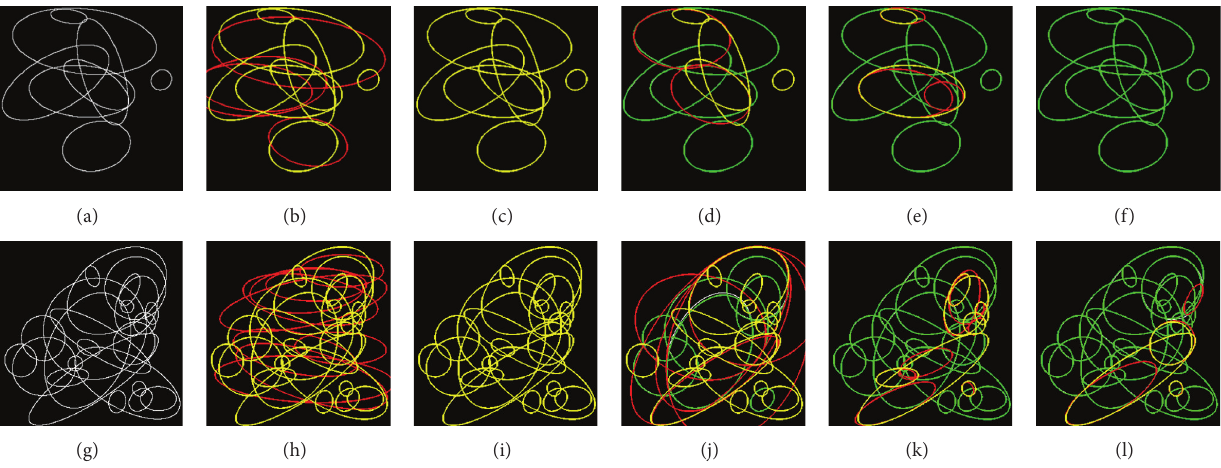
Figure 10: Two sets of detection results by each method. (a, g) are two images with 𝑁 = 8 and 𝑁 = 24 , (b, h), (c, i), (d, j), (e, k), and (f, l) are the detection results by RHT, UPW, KIM, MAI, and the proposed method, respectively, where green ellipses are correct detections, yellow ellipses are false negatives, and red ellipses are false